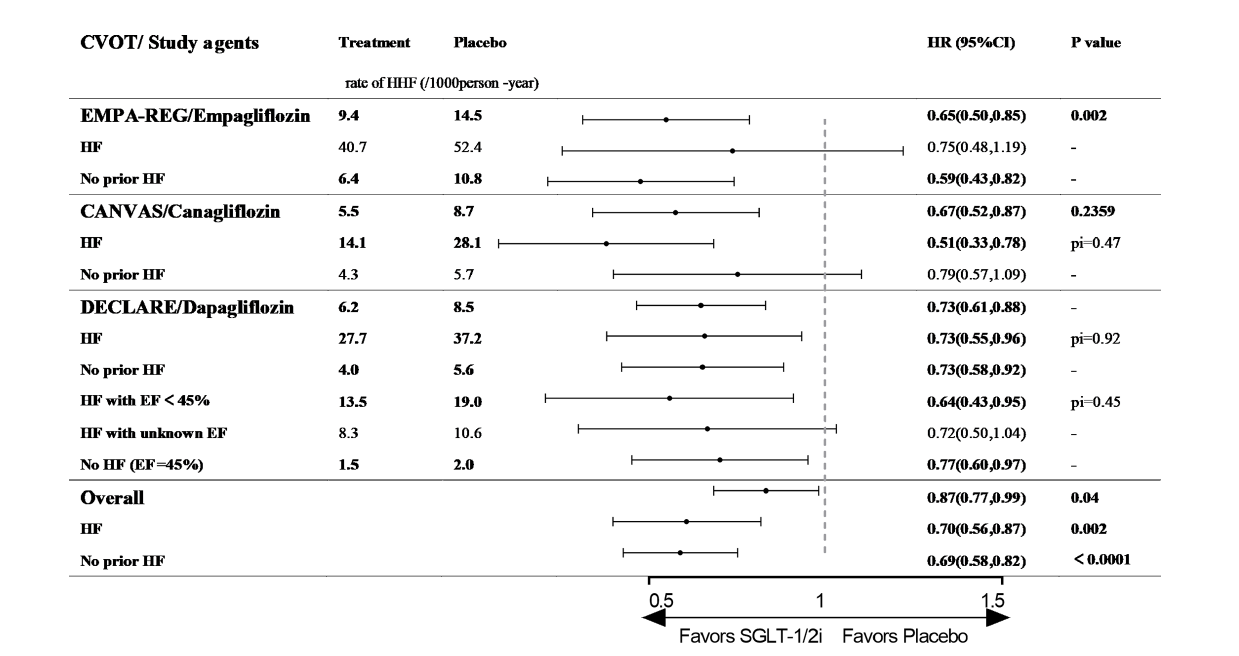
FIGURE 3 | The effect of SGLT-2is or SGLT-2/1is on HHF in type 2 diabetic patients with and without history of HF. CVOT, cardiovascular outcome trial; HHF, hospitalization for heart failure; HF, heart failure; EF, ejection fraction; pi, p value of interaction; EMPA-REG OUTCOME, The Empagli fl ozin Cardiovascular Outcome Event Trial in Type 2 Diabetes Mellitus Patients; CANVAS, The Canagli fl ozin Cardiovascular Assessment Study; DECLARE, The Dapagli fl ozin Effect on Cardiovascular